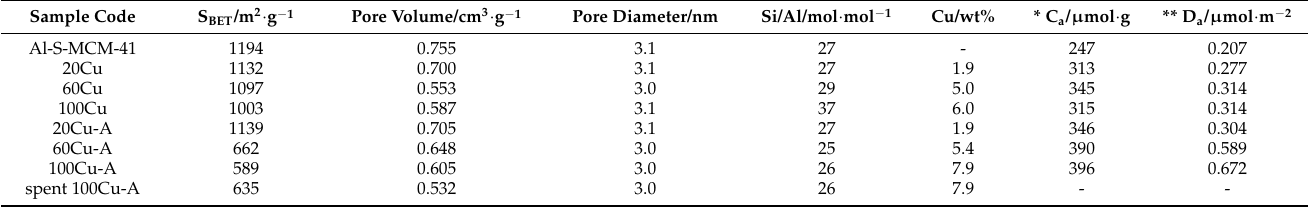
* C a —surface concentration of acid sites related to 1 g of the sample; ** D a —surface density of acid sites—concentration of acid sites on 1 m 2 of the sample.